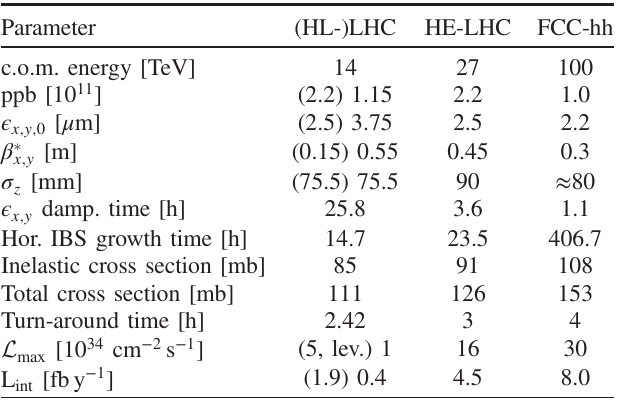
TABLE I. Key parameters for (HL-)LHC, HE-LHC and FCC- hh for proton operation.